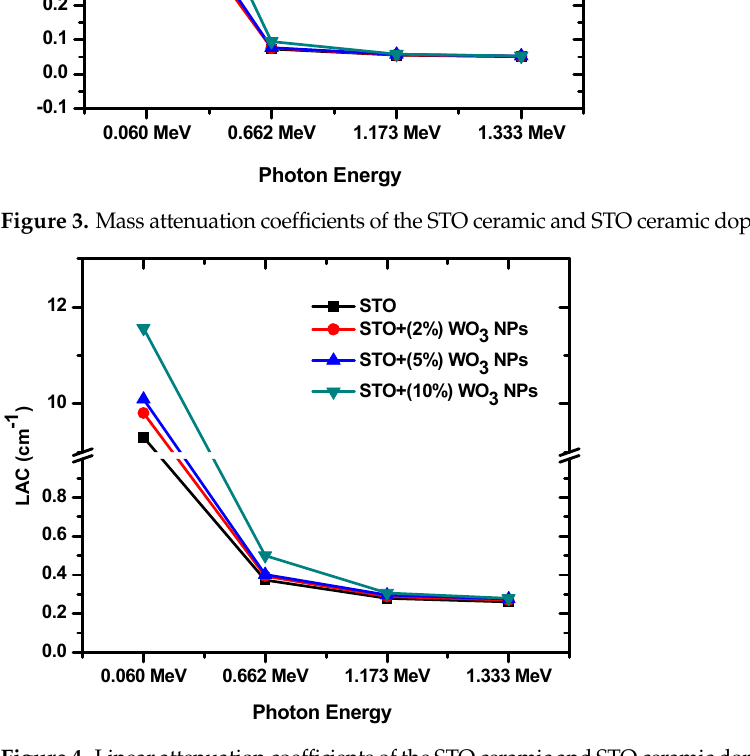
Figure 4. Linear attenuation coefficients of the STO ceramic and STO ceramic doped with x% of WO 3 NPs. The half-value layer (HVL) of the investigated samples is graphed in Figure 5 against energy. For all the tested ceramics, their HVL values correlate with energy. For example, for the ceramic with 2% WO 3 nanoparticles, its HVL values are equal to 0.071 cm, 1.760 cm, 2.407 cm, and 2.564 cm at 0.060 MeV, 0.662 MeV, 1.173 MeV, and 1.333 MeV, respectively. As the energy increases, more radiation can pass through the material, which is why this relationship occurs. Therefore, a larger thickness is required to absorb half of the total photons, leading to a greater HVL. The figure also shows that HVL